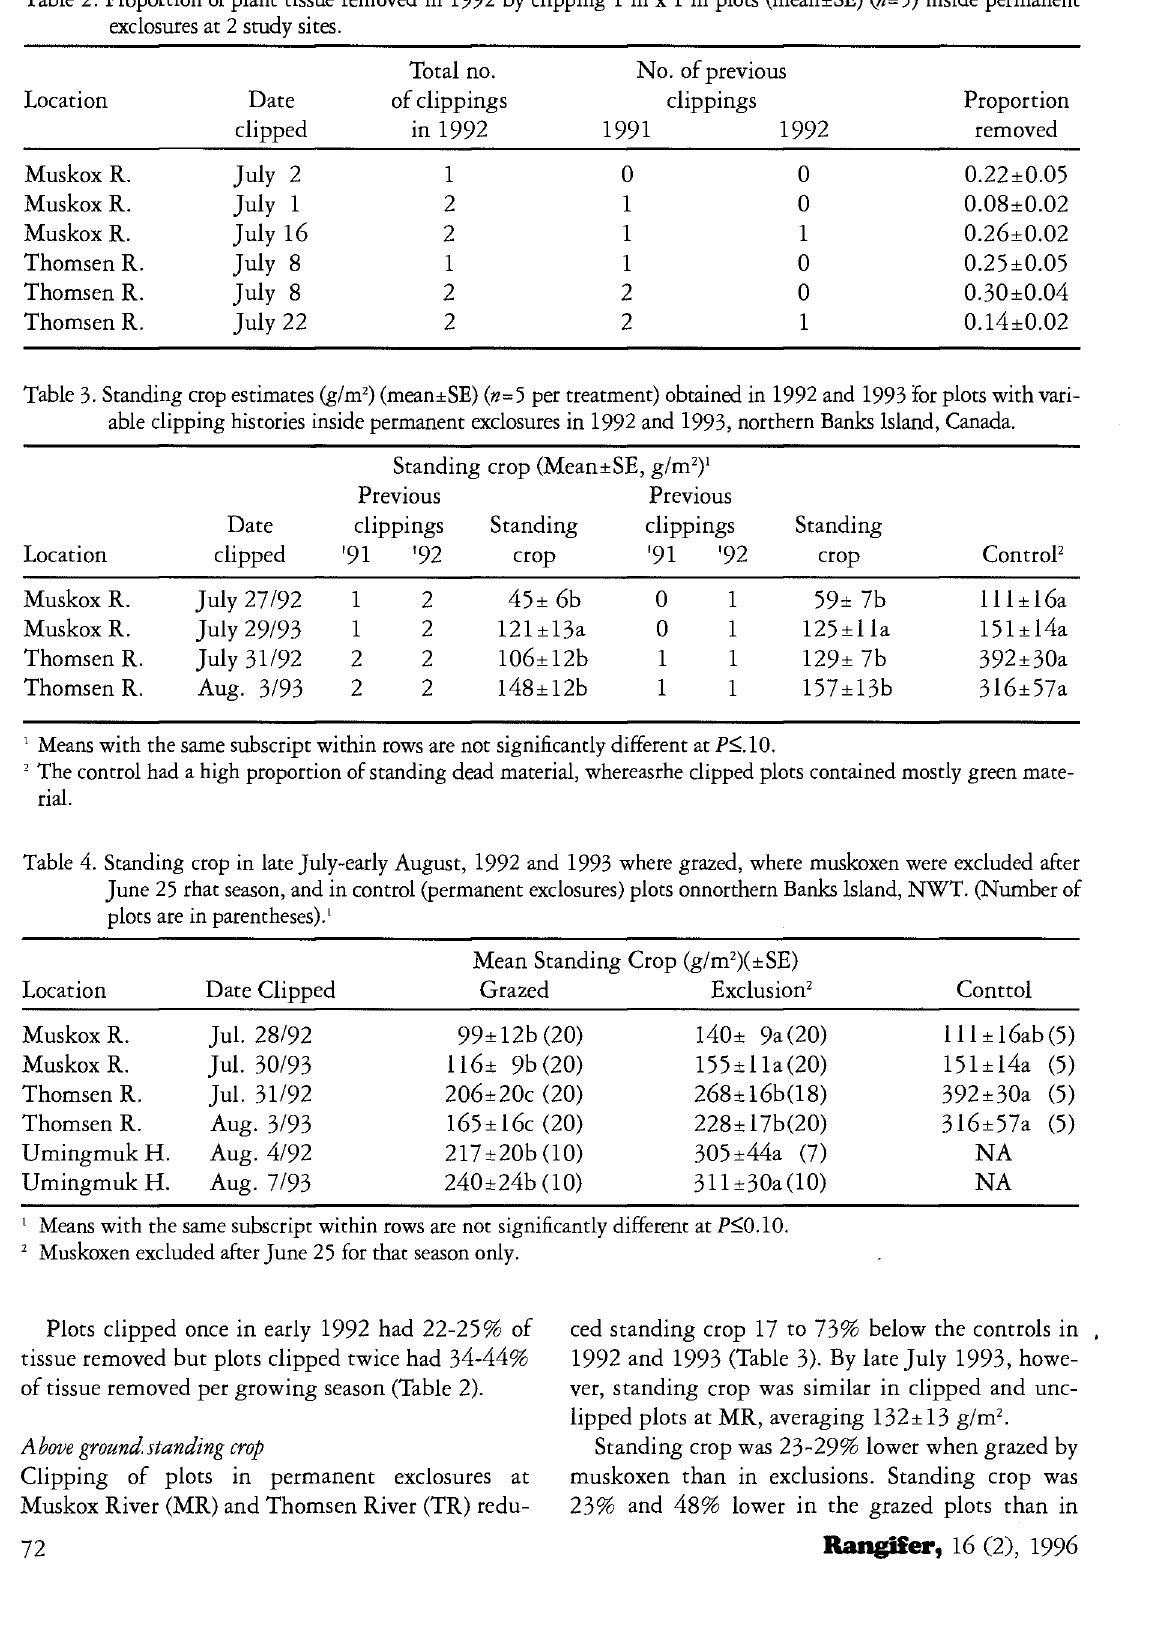
Table 2. Proportion of plant tissue removed in 1992 by clipping 1 m x 1 m plots (mean±SE) (n=5) inside permanent exclosures at 2 study sites.